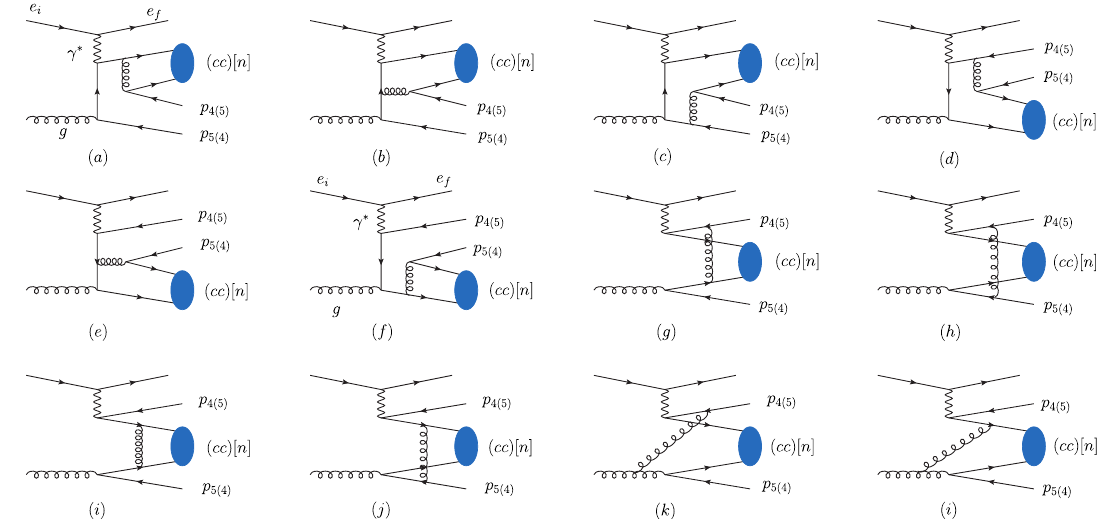
Figure 2 . The Feynman diagrams for the subprocesses e + g ! e + ( cc )[ n ] + (cid:22) c + (cid:22) c ( p 4 $ p 5 ). where 1 = ( N N ) is the colour and spin average factor; jMj 2 and d (cid:8) are squared matrix c s element and the 4-body phase space, respectively. In the following subsections, we depict the method of how to calculate jMj 2 and d